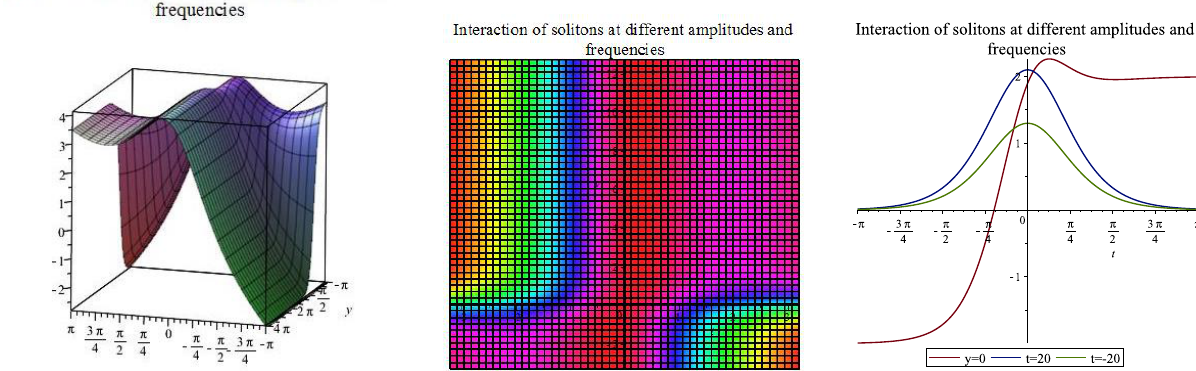
Figure 9. Wave depiction of soliton interaction at different amplitude with x =